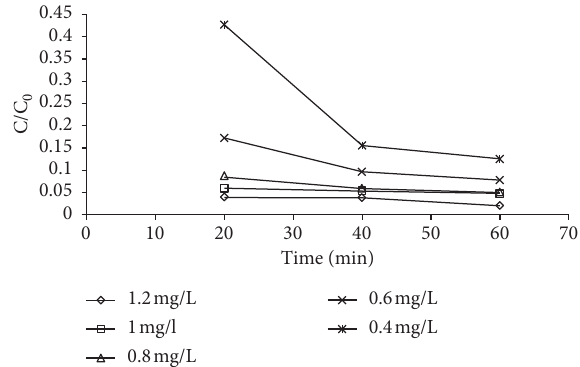
Figure 4: Impact of initial trifluralin concentration on process efficiency (persulfste concentration, 40 µ M, PH � 9, UV � 6 W).